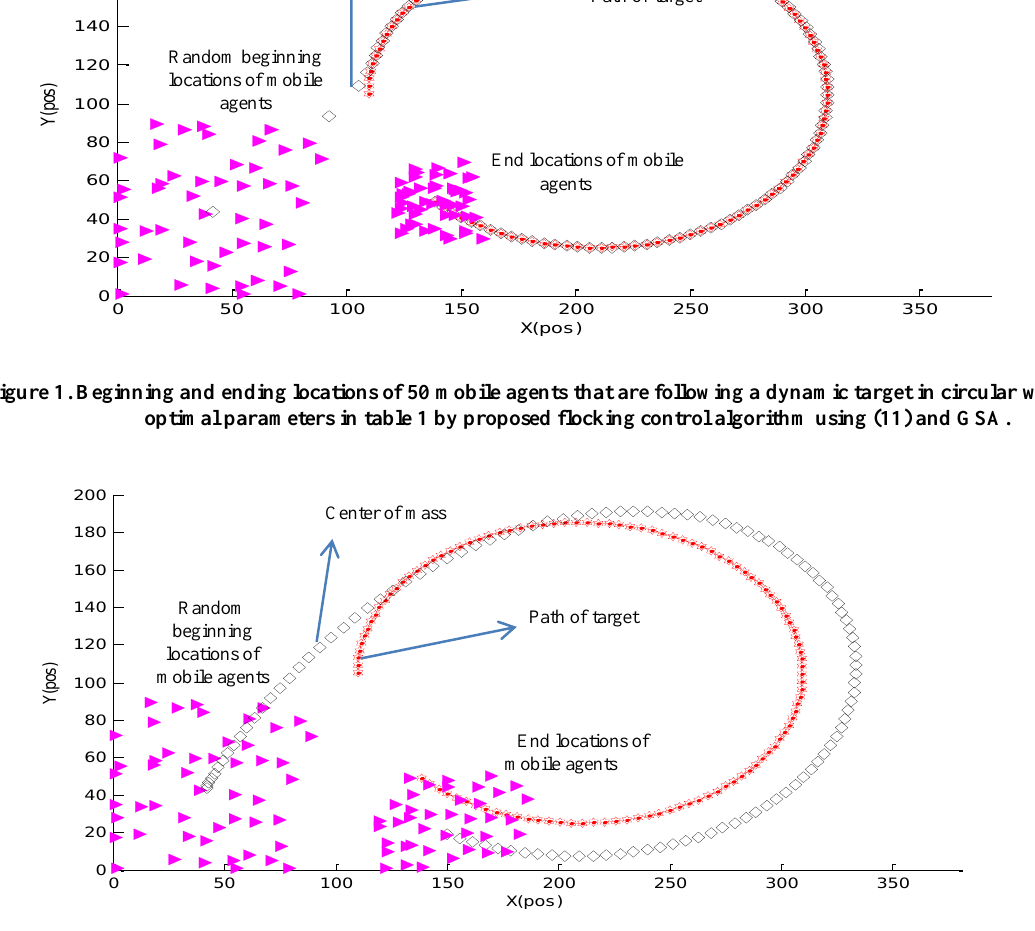
Figure 2. Beginning and ending locations of 50 mobile agents that are following a moving target in circle wave path without iteration forces using (4) [11].